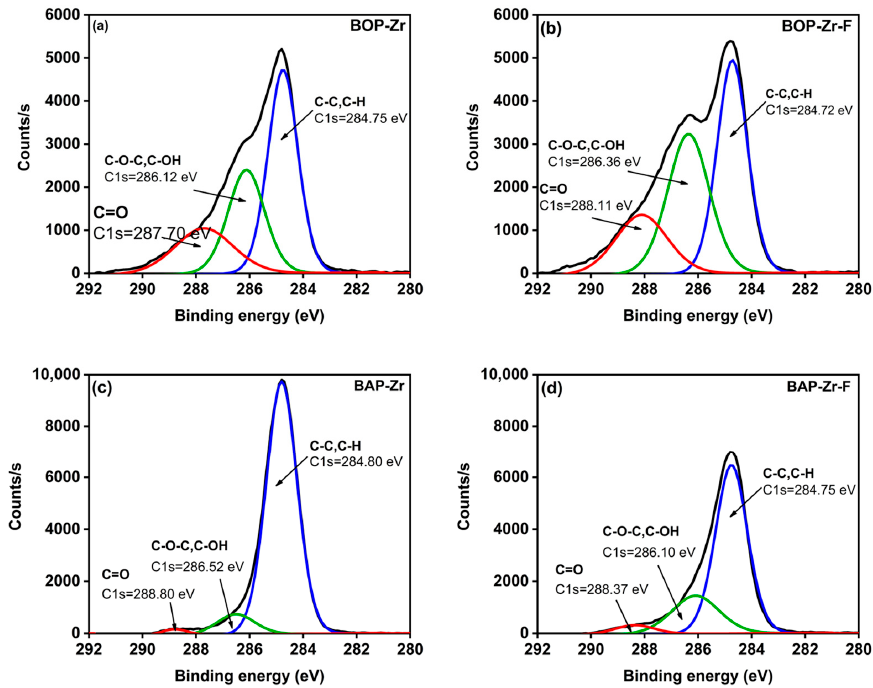
Figure 9. Deconvoluted XPS spectra for C1s: ( a ) BOP-Zr, ( b ) BOP-Zr-F, ( c ) BAP-Zr, and ( d ) BAP-Zr-F. The respective deconvolution for O1s, in BOP-Zr and BAP-Zr spectra, are shown in Figure 10. The XPS curve present three representative peaks. The first one, located in the binding energies (eV) 530.30 and 529.91 for BOP-Zr and BAP-Zr, respectively, is associated with the O 2 − of Zr of the metal oxide (M-O). The second peak is located at 532.50 for BOP-Zr and 532.35 for BAP-Zr, assigned to the hydroxyl group (OH − ) of Zr. Finally, the binding energies (eV) 534.63 (BOP-Zr) and 534.18 (BAP-Zr) are attributed to the adsorbed water (H 2 O) [61–63]. The bioadsorbents that had contact with fluoride showed important